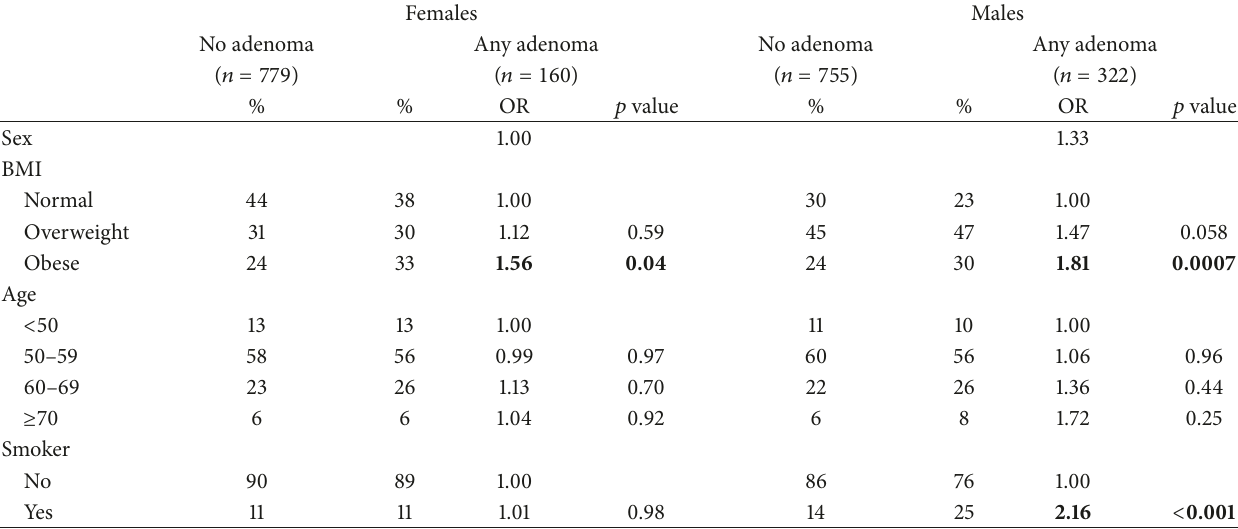
Table 5: Risk of neoplasia by sex, adjusted for BMI, age, and smoking